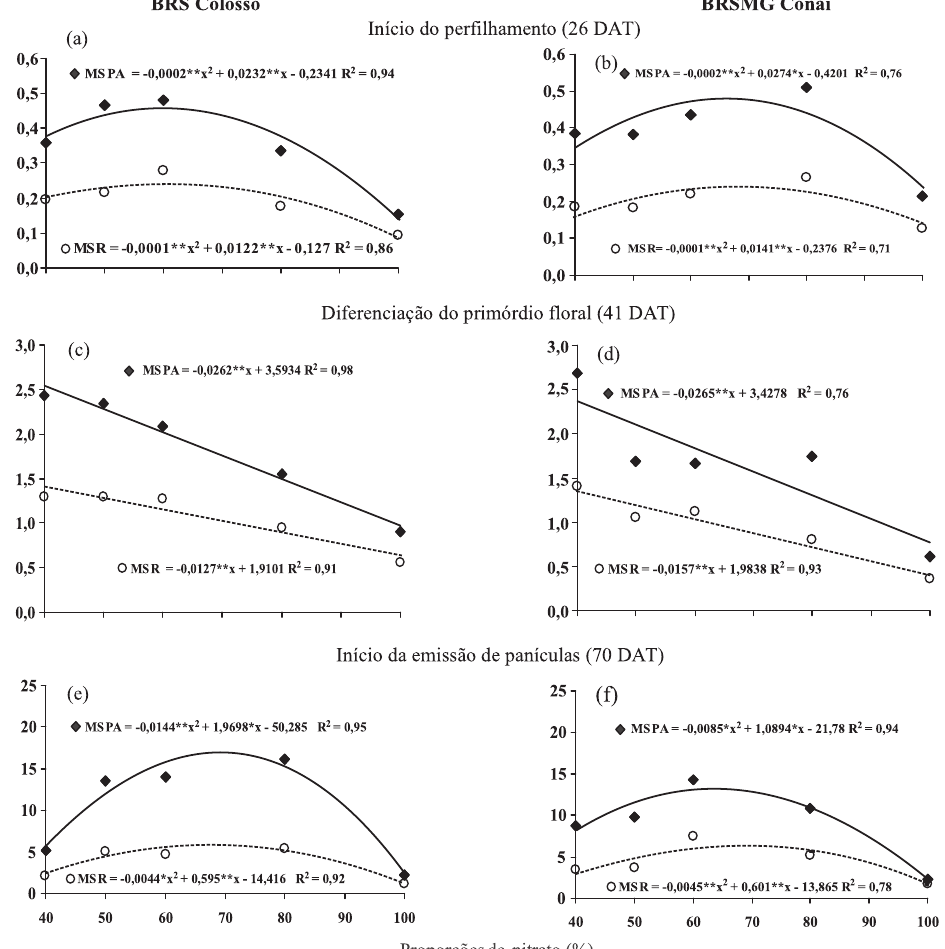
figura 1. matéria seca da parte aérea (msPA) e matéria seca de raízes (msr) das cultivares de arroz brs Colosso (a, c e e) e brsmG Conai (b, d e f) em função das proporções de nitrato na solução nutritiva, em diferentes estádios de crescimento. dAt: dias após o transplantio. *e**: significativo em níveis de p < 0,05 e p < 0,01,